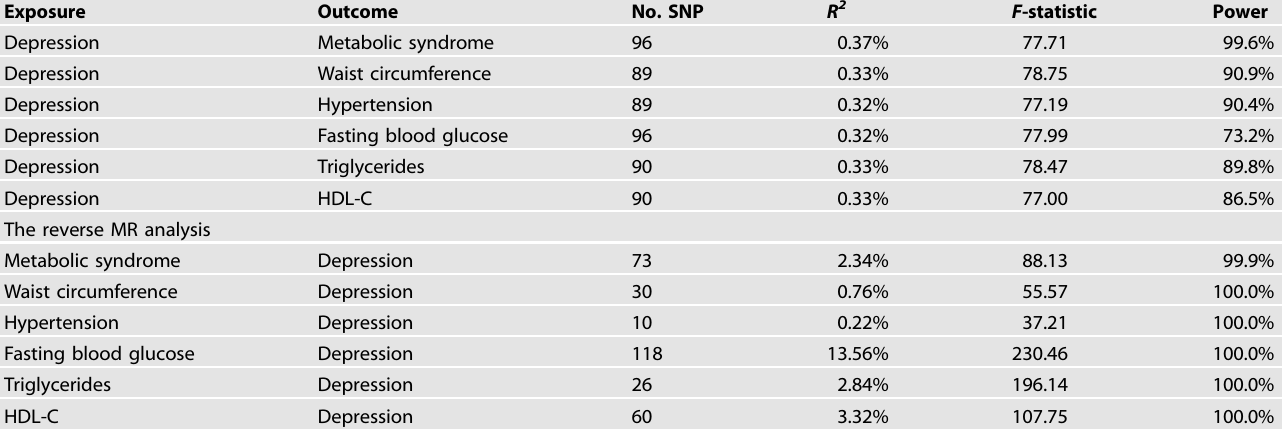
Table 1. The R 2 and F -statistics for the genetic instruments and the power for